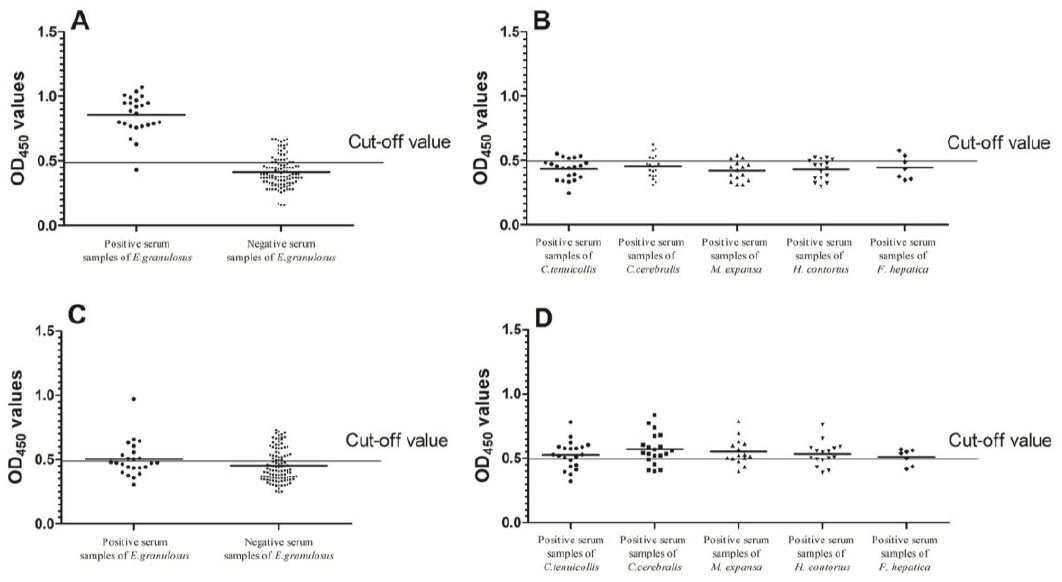
Figure 5. Specificity and sensitivity of the indirect ELISA. The cut-off value is 0.495. ( A ) The recombinant Eg-LAP specificity and sensitivity of indirect ELISA for E. granulosus diagnose; ( B ) The cross reactivity of rEg-LAP of indirect ELISA; ( C ) The hydatid cysts antigen specificity and sensitivity of indirect ELISA for E. granulosus diagnose; ( D ) The cross reactivity of hydaid cycts antigen of indirect ELISA.